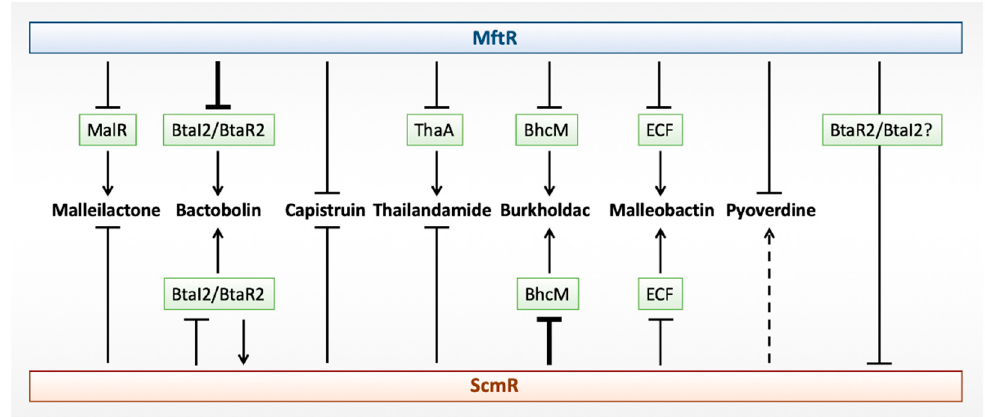
Figure 3. Regulation of biosynthetic gene clusters by Major Facilitator Transport Regulator (MftR) and Secondary Metabolite Regulator (ScmR). Cluster-specific regulators, where known, are identified in green. Repression is shown as lines, and activation as arrows. Deletion of mftR or scmR results in the greatest upregulation of Bactobolin and Burkholdac, respectively, as indicated by heavier lines. ScmR-mediated activation of Pyoverdine biosynthetic genes is marginal (dotted line). For ScmR-mediated regulation of the Bactobolin biosynthetic gene cluster, direct repression of btaI2 was inferred, with BtaR2 reciprocally activating scmR .